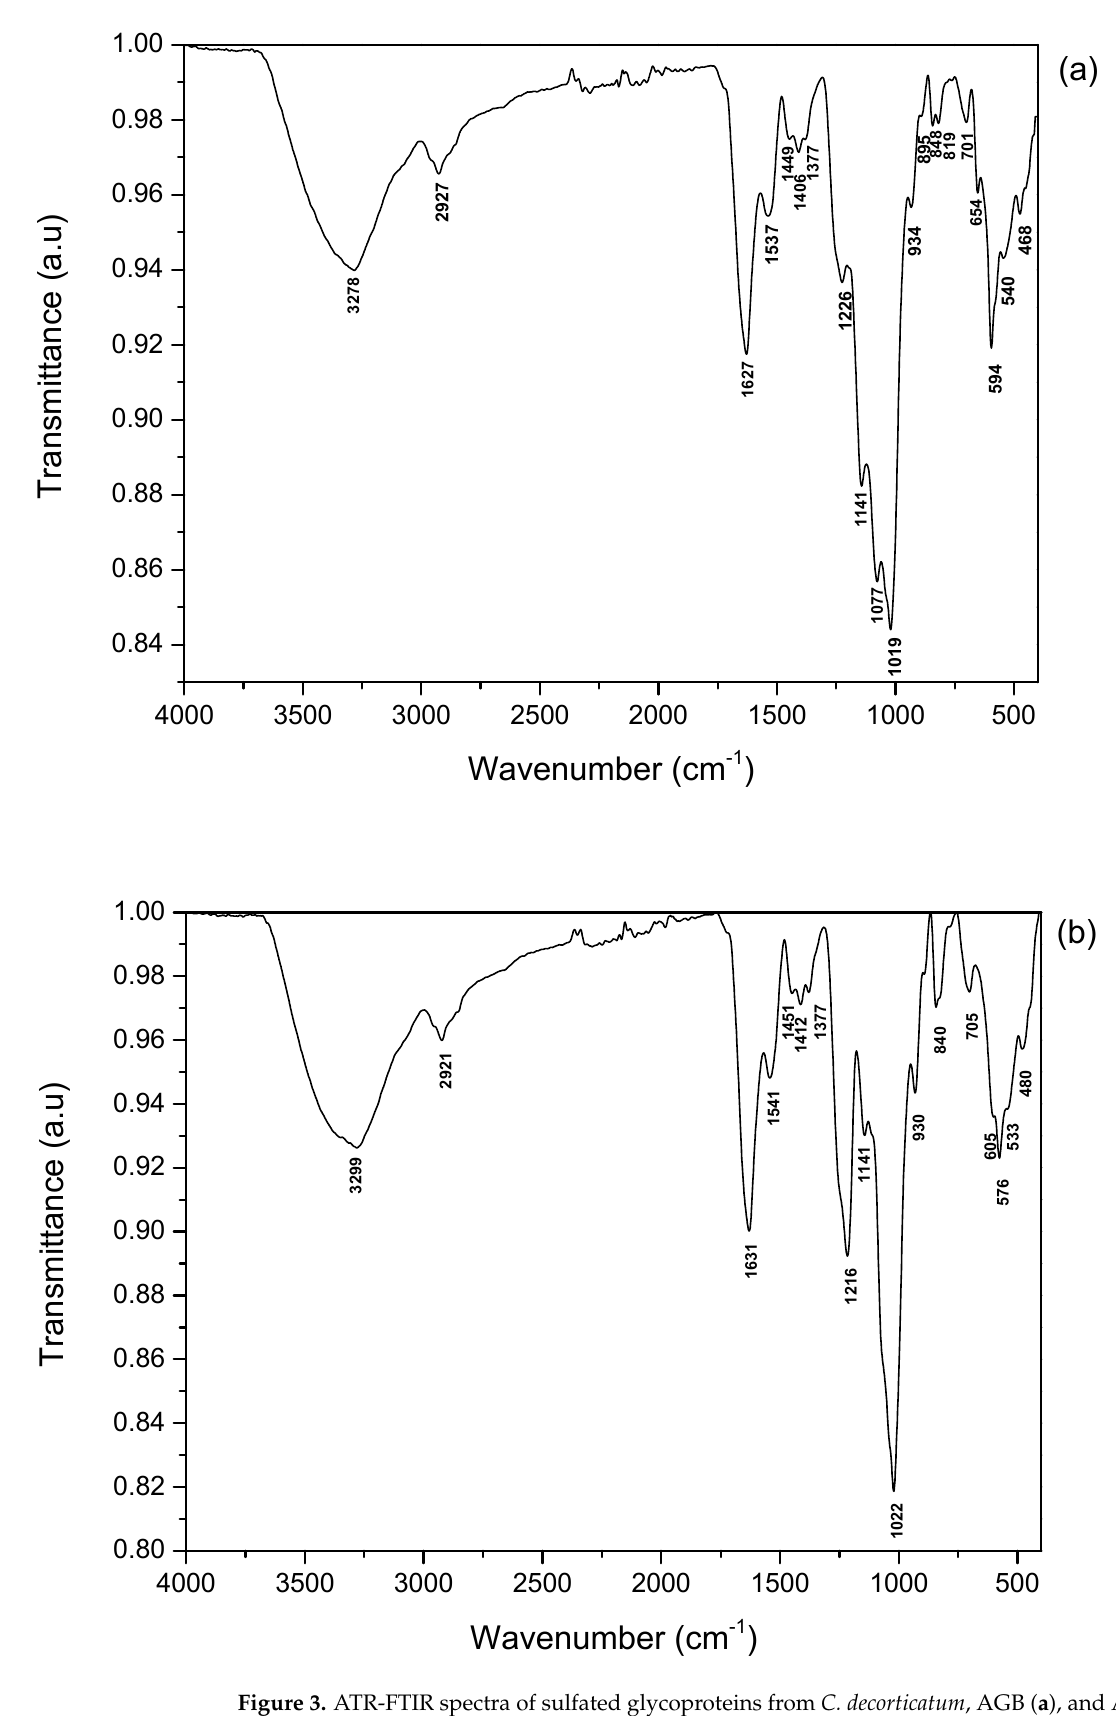
Figure 3. ATR–FTIR spectra of sulfated glycoproteins from C. decorticatum , AGB ( a ), and AGP ( b ).